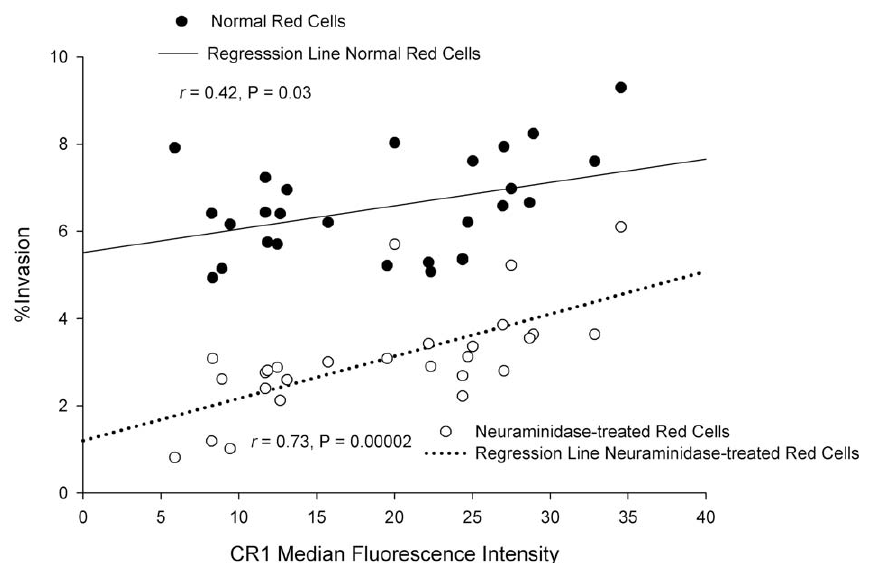
Figure 7. Correlation between CR1 median fluorescence intensity (MFI) and invasion of erythrocytes by P. falciparum 7G8. Erythrocytes from 27 healthy donors were used. To control for day-to-day variation the percent invasion as well as the CR1 MFI were normalized to an erythrocyte standard sample that was used in every experiment. The CR1 MFI was re-measured once in 4 samples with extreme values. In 19 donors the invasion assay was repeated 1–3 times. When more than one measurement was done, the mean was used for normalization.